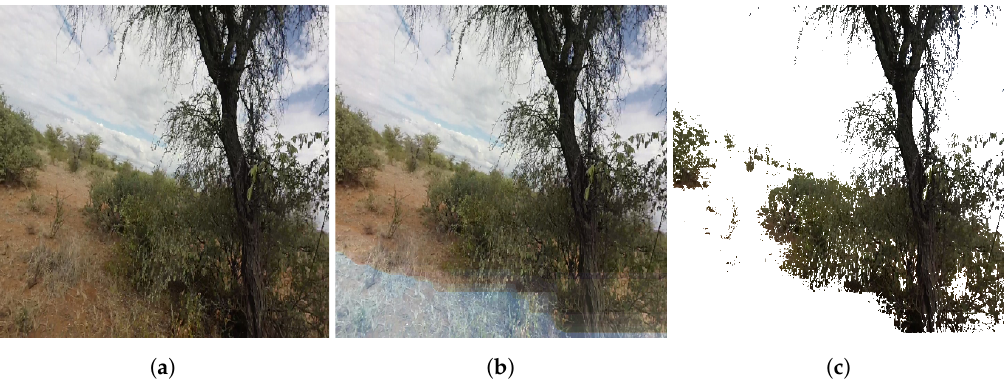
Figure 5. Noise removing filter, with ( a ) showing an example of a noisy image photographed against the sunlight, ( b ) demonstrating the removal of undesired contrast regions, and ( c ) displaying the filtered result, where sand, grass, and sky are removed.